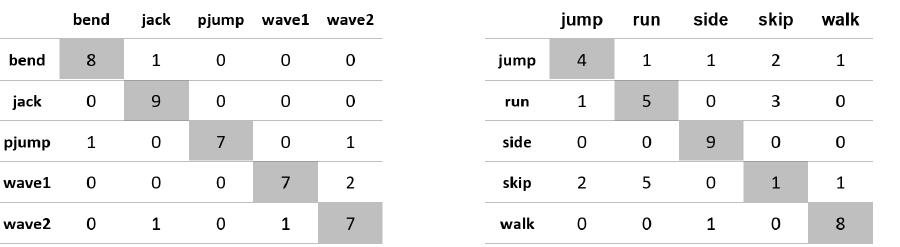
Figure A13. Confusion matrices for the experiment using the ‘lower-occlusion’ database, MBR width and C1 correlation.